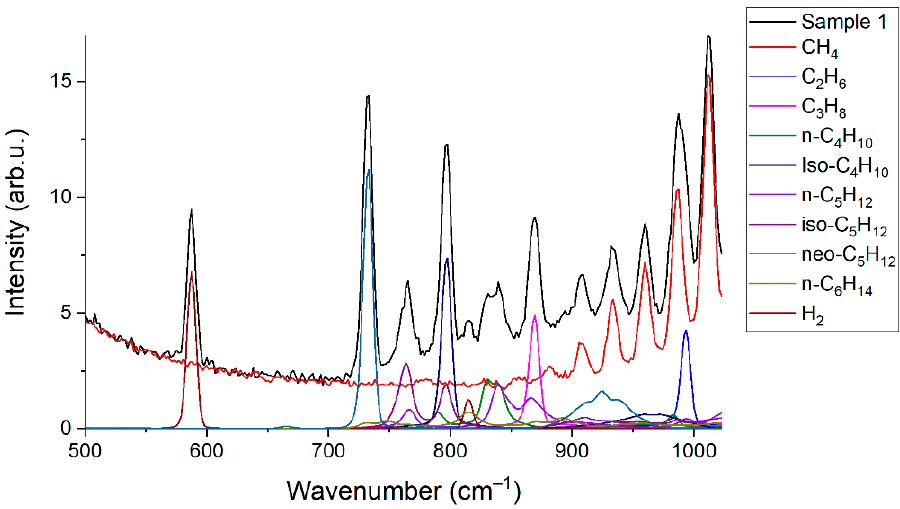
Figure 6. Contributions of the species to the spectrum of sample 1.